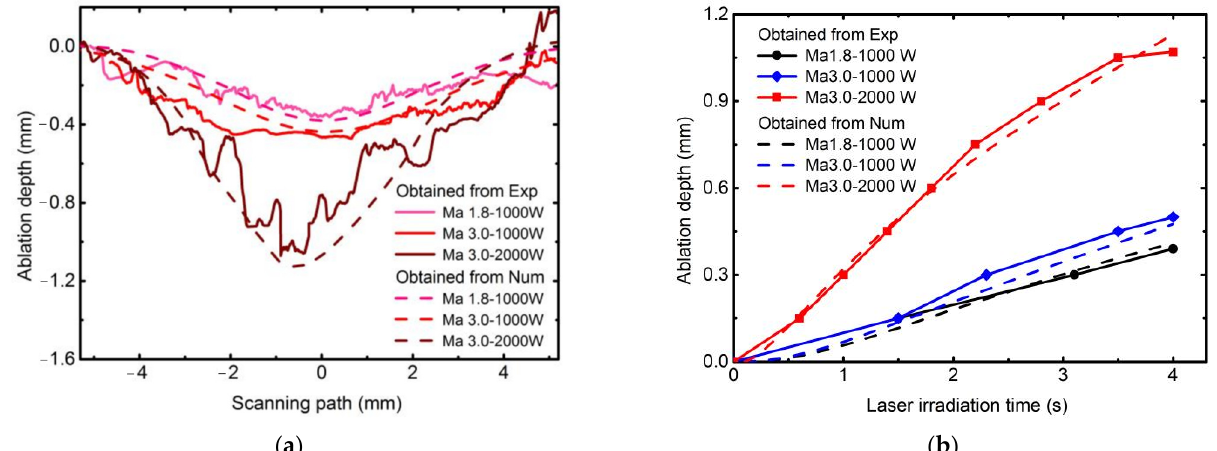
Figure 10. Comparison of experimental and numerical results. ( a ) Profile over the ablation surface; ( b ) instantaneous ablation depth.